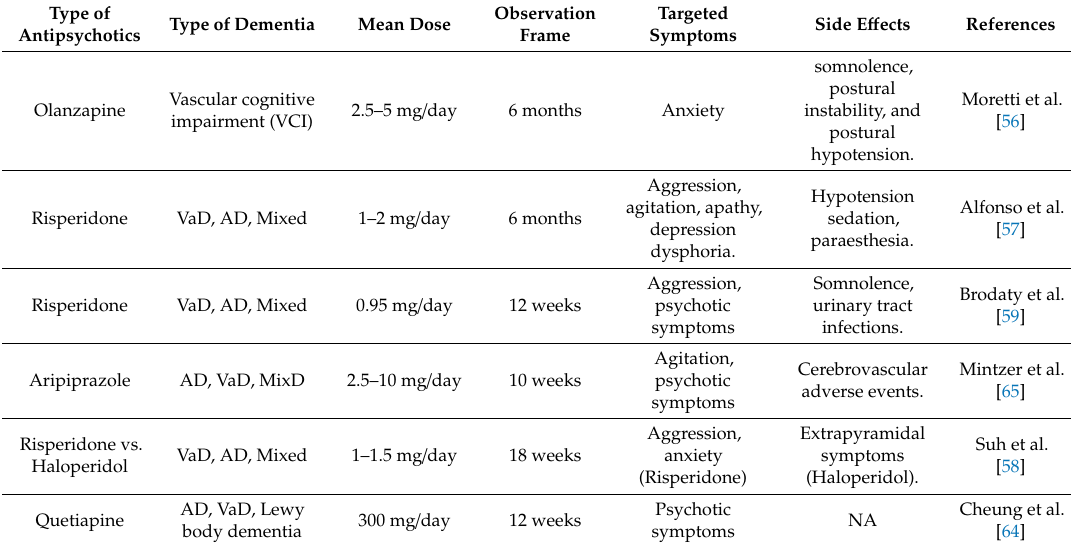
Table 2. Antipsychotic prescription patterns according to specific dementia sub-types (VaD, AD and